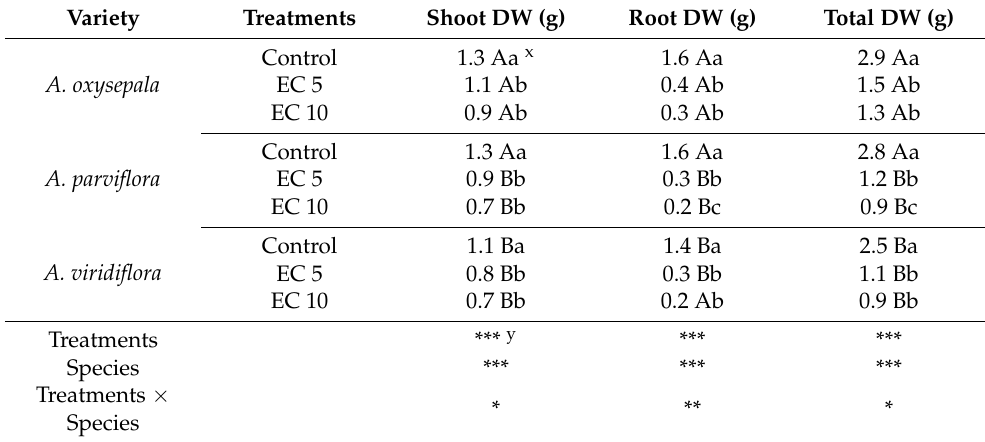
Table 7. Shoot dry weight (DW), root DW and total DW of A. oxysepala , A. parviflora , and A. viridiflora irrigated with tap water (control) and salt solution at an electrical conductivity (EC) of 5 dS · m − 1 (EC 5) and 10 dS · m − 1 (EC 10).